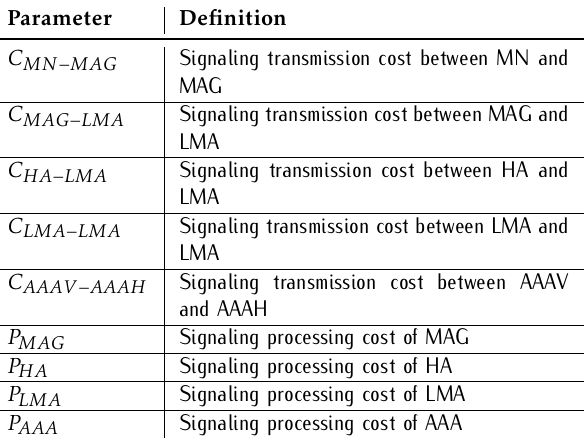
Table 1. The parameter